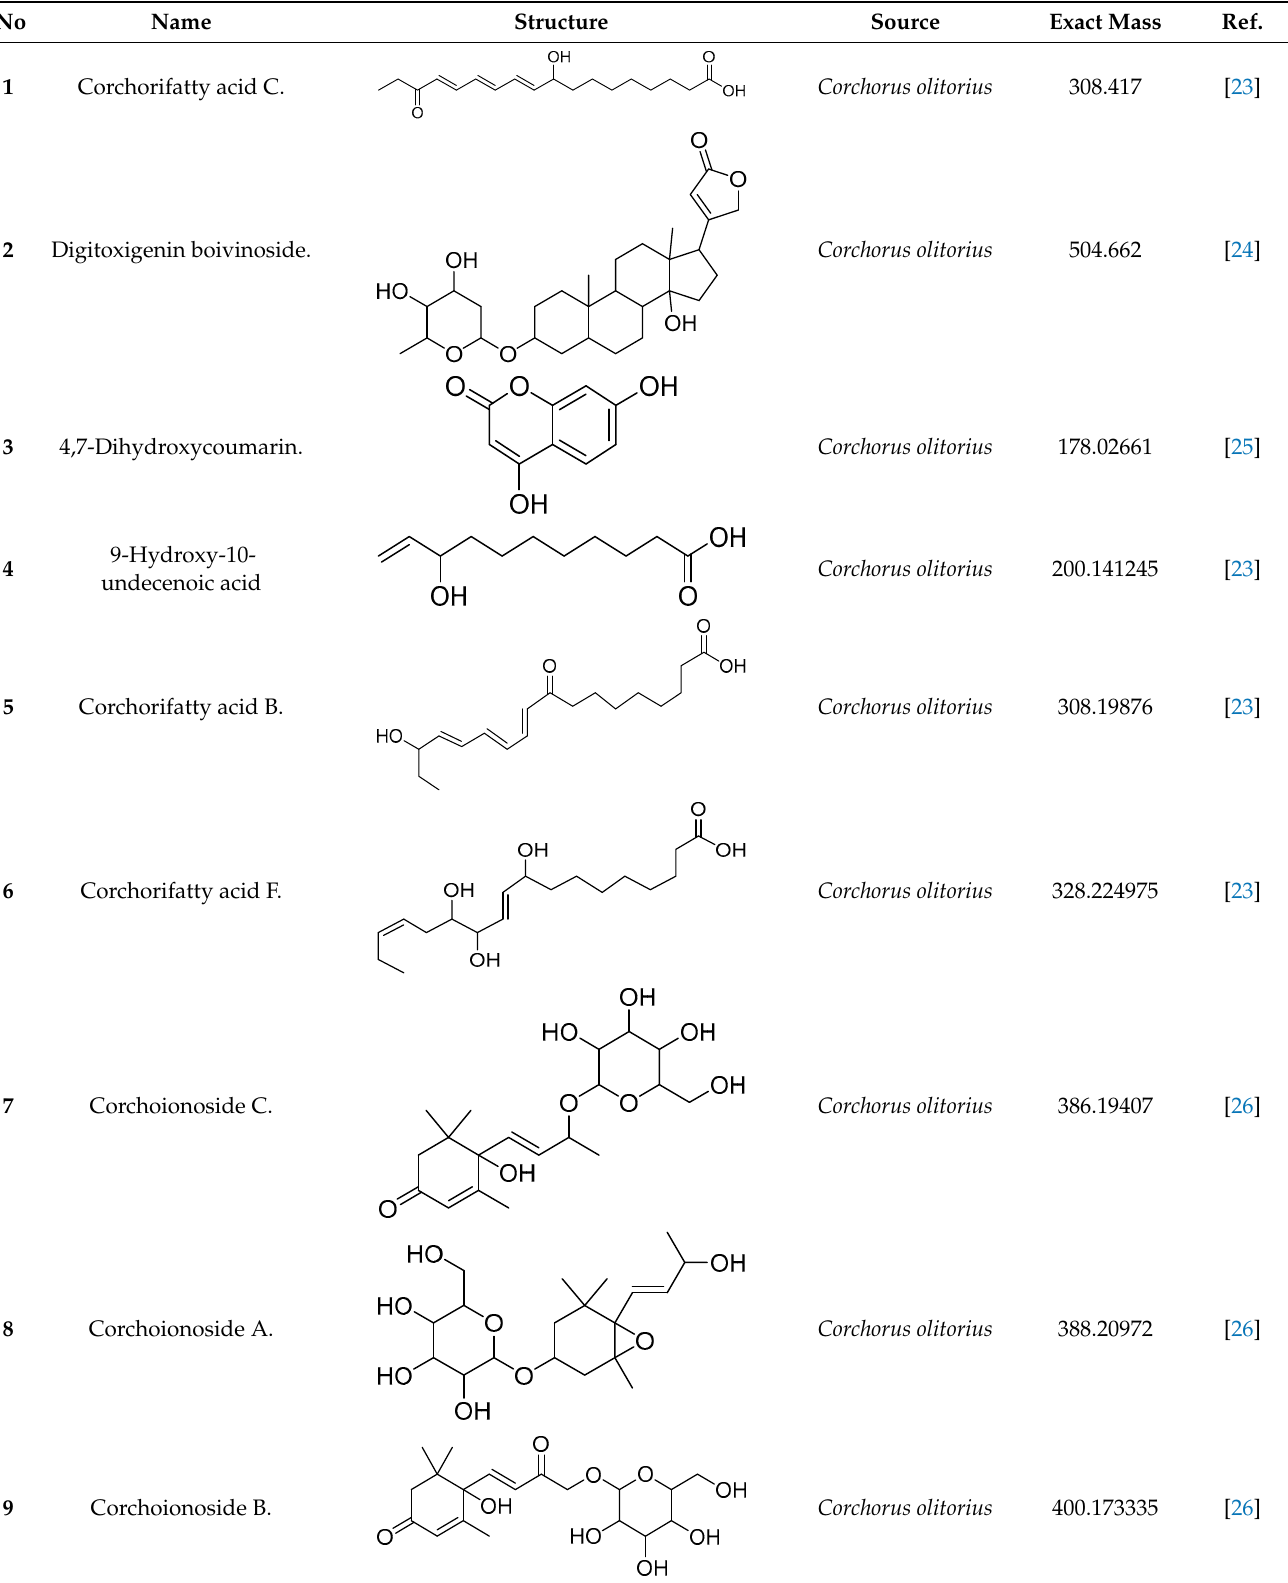
Table 1. Dereplicated compounds from Corchorus olitorius seeds.